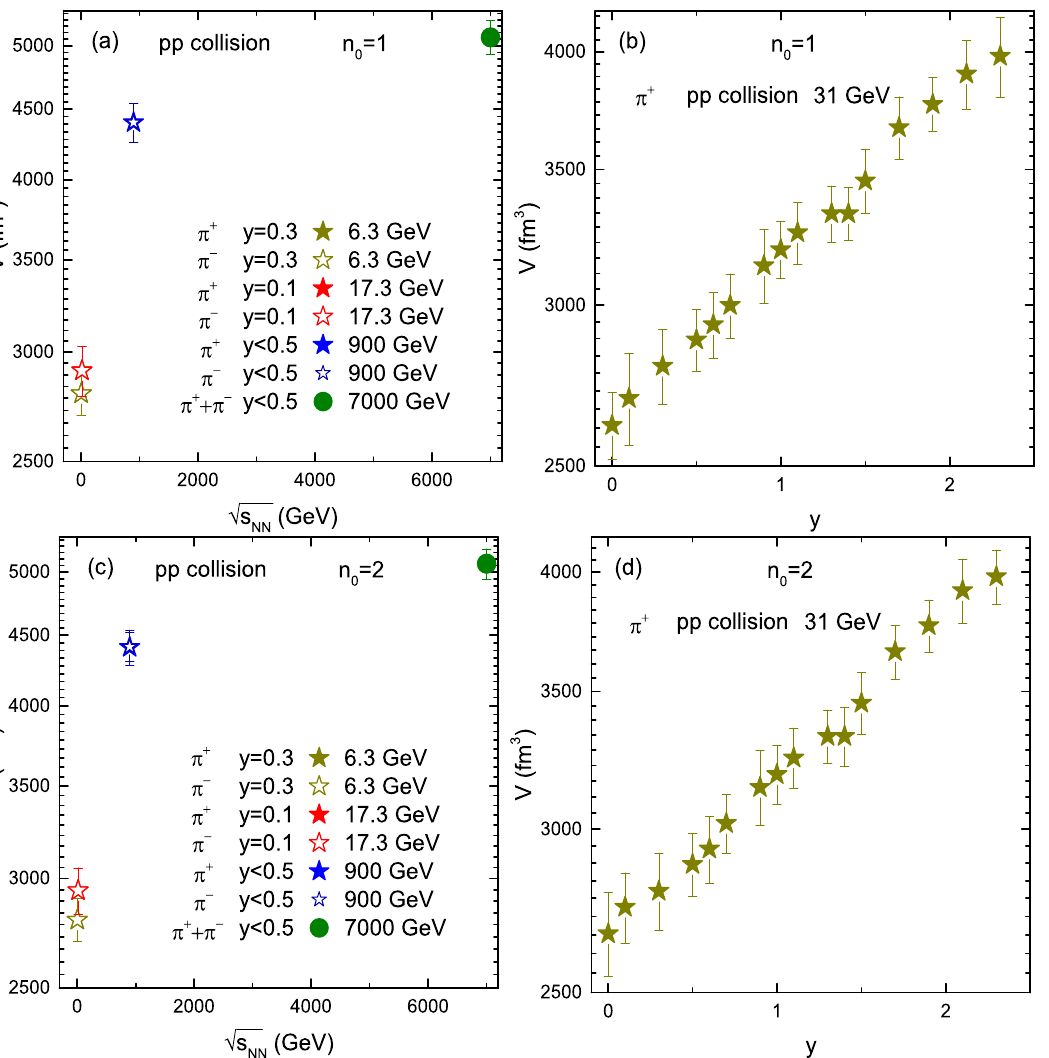
Figure 4. Dependence of kinetic freeze-out volume on collision energy as well as rapidity at 31 GeV. Panels ( a , c ) show the dependence of V on collision energy by using the flow profile n 0 = 1 and 2, respectively, in the TBW model, while panels ( b , d ) show its dependence on rapidity at 31